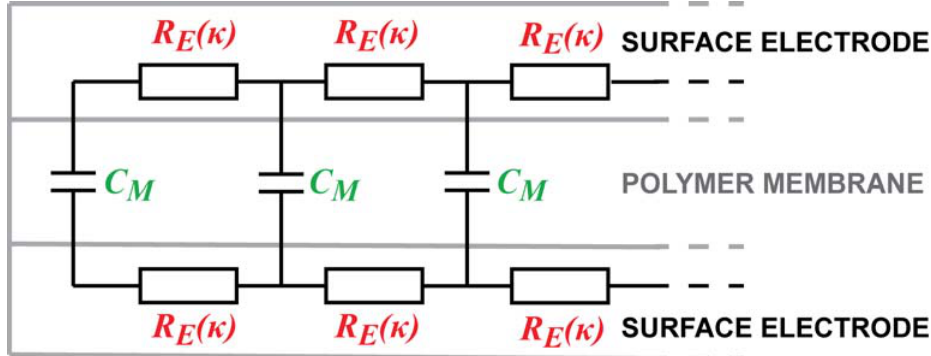
Figure 14. A distributed model of a CPC